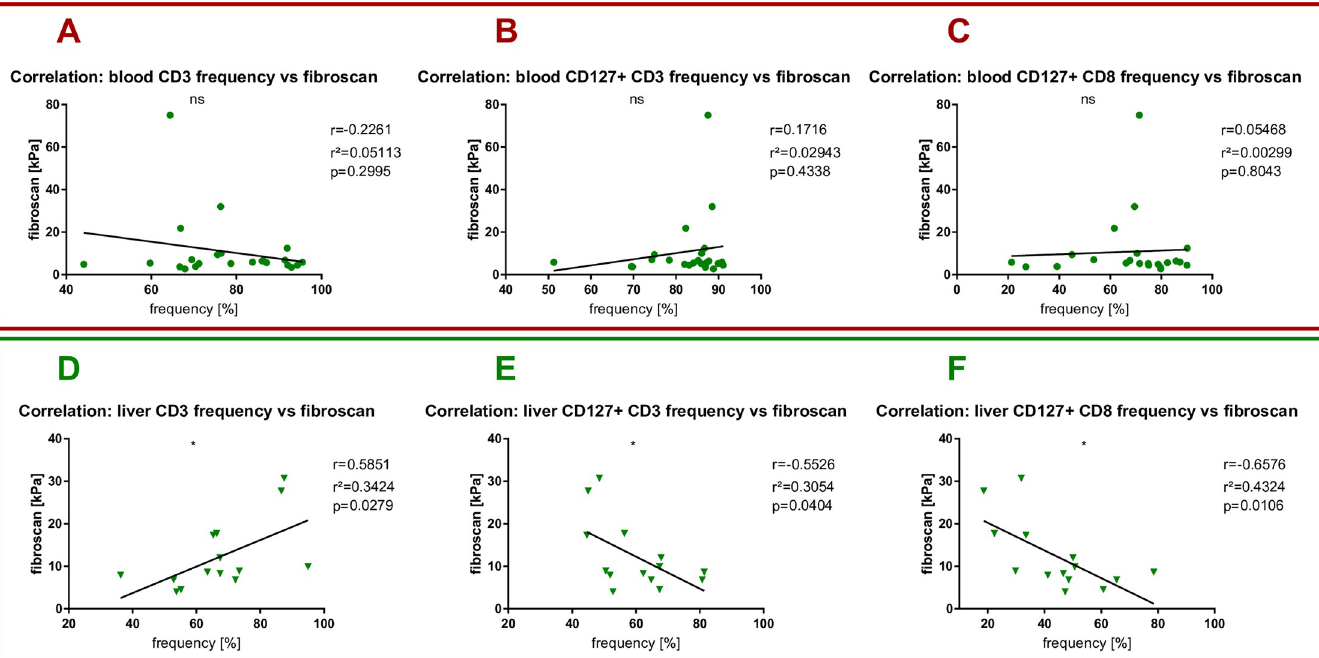
Fig 4. T cells and hepatic fibrosis in NAFLD. Each spot represents one patient. (A-C) PBMC data. (D-F) intrahepatic data. (A) Pearson’s correlation between peripheral T cell frequency and fibroscan with Pearsons r, r 2 and p value. (B) Pearson’s correlation between peripheral CD127 positive T cell frequency and fibroscan with Pearsons r, r 2 and p value. (C) Pearson’s correlation between peripheral CD127 positive CD8 positive T cell frequency and fibroscan with Pearsons r, r 2 and p value. (D) Pearson’s correlation between intrahepatic T cell frequency and fibroscan with Pearsons r, r 2 and p value. (E) Pearson’s correlation between intrahepatic CD127 positive T cell frequency and fibroscan with Pearsons r, r 2 and p value. (F) Pearson’s correlation between intrahepatic CD127 positive CD8 positive T cell frequency and fibroscan with Pearsons r, r 2 and p value. � p < 0.05.